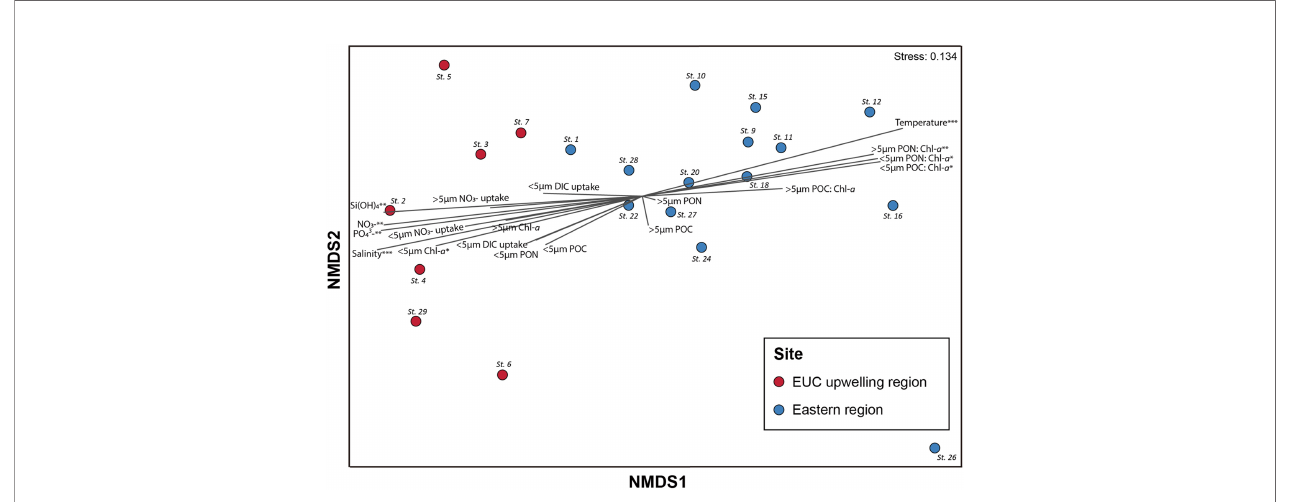
FIGURE 5 | Non-metric multidimensional scaling (NMDS) of the protistan assemblages in the Gala ́ pagos Archipelago. NMDS (stress = 0.134) of samples based on protist composition determined by sequence reads obtained from DNA metabarcoding (V4 region of 18S rRNA gene). Samples were classi fi ed according to the sites collected: Equatorial undercurrent upwelling (EUC) region (red circle) and eastern region (blue circle) sites. Vectors illustrate the relative directions and magnitudes of oceanographic and productivity variables ’ contribution to dissimilarities among samples. Asterisks indicate signi fi cance at p-values of less than 0.05 (*), 0.01 (**), and 0.001 (***). The R 2 and p-values of each vector are provided in Supplementary Table 3